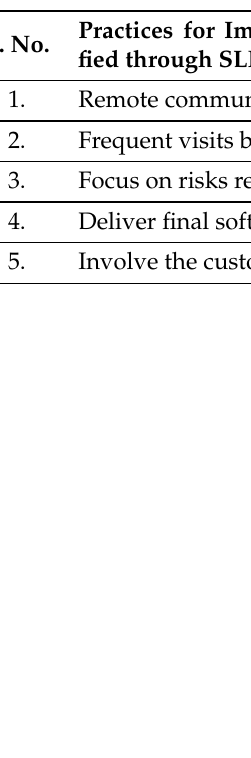
Table 16. Practices for implementing risk